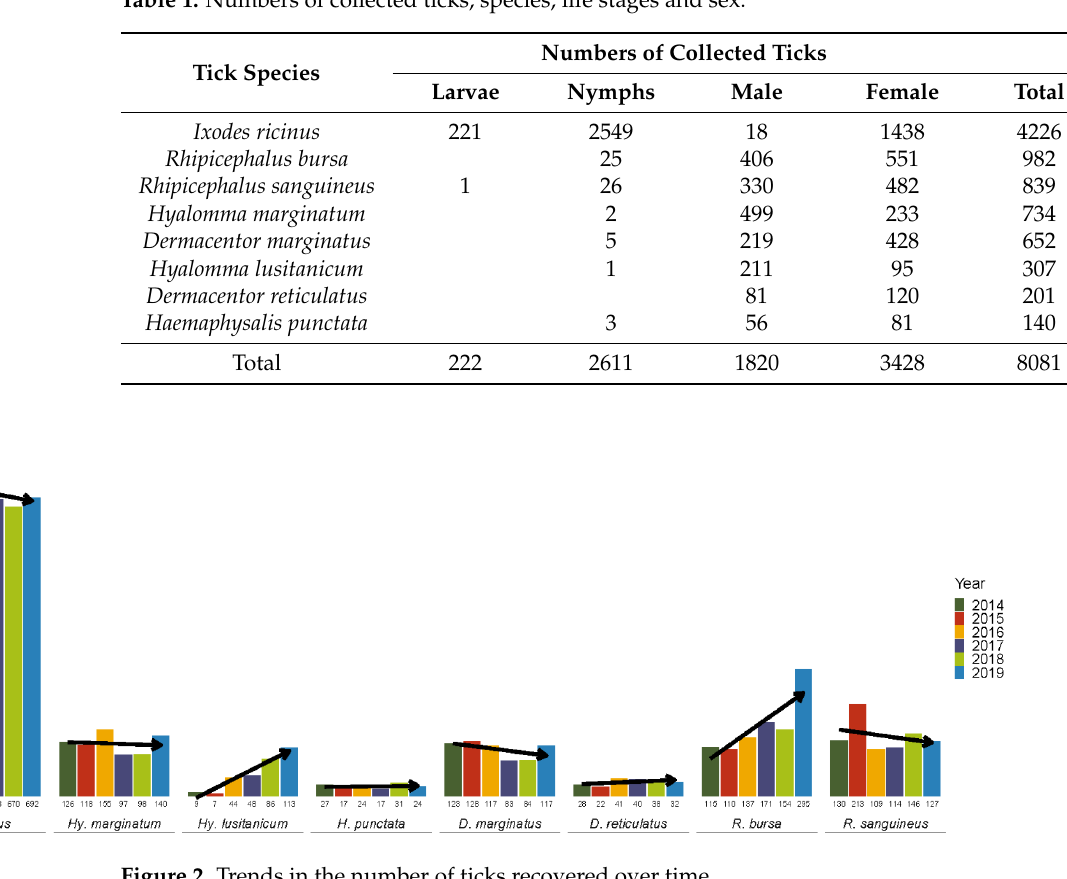
The highest number of tick bites (78%, n = 6303) was reported during spring and summer (April to July) and the lowest in winter (January and early February) (8.90%, n = 719). Ixodes ticks were the most frequent and widely distributed species (Figure 4), and although they were detected throughout the year, their highest detection levels were in spring, autumn and early winter for the adult stage and spring and summer for the nymphs (June mainly). Adult stages of the genus Hyalomma were removed throughout the year, although very sporadically in winter and autumn, with peak activity in spring and early summer for both species (June and July). Rhipicephalus had one activity peak in spring with a decrease in summer (most bites in May and June) and practically disap- peared in autumn and winter in the case of R. bursa . For R. sanguineus , despite the de- creases in the number of cases, it was still active during these seasons. Both species of Dermacentor were active all year, although they showed pronounced seasonality with two annual peaks of maximum activity in spring and autumn for D. marginatus and autumn and winter for D. reticulatus , with very little or no presence in summer. Most D. margina- tum bites were in April and May, with slightly lower peaks in October and March, while most bites by D. reticulatus occurred in December and March, with a smaller peak in April. Haemaphysalis had a very low occurrence and was limited to spring (May and June).